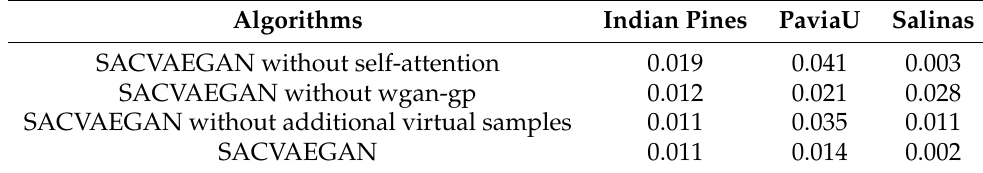
Figure 11. Illustration of the spectral features on the Indian Pines ( a – e ), PaviaU ( f – j ), Salinas ( k – o ) data sets. The orange line represents the mean, the green line represents the mean add the variance, and the blue line represents the mean minus the variance. Table 14. SID when self-attention, WGAN-GP, and additional virtual samples are